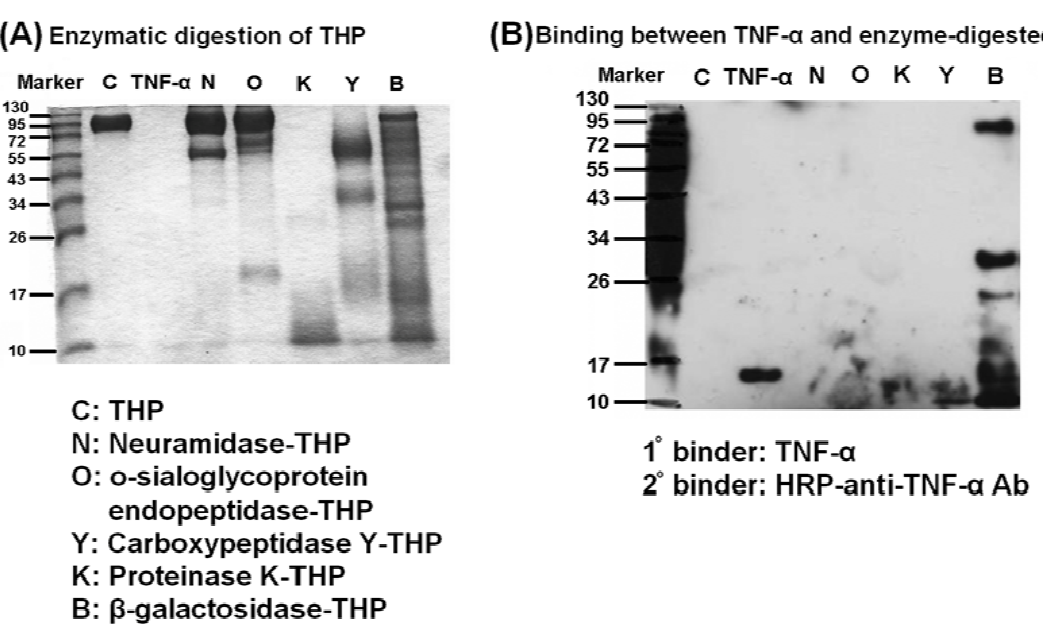
Figure 5. Binding capacity of intact THP and enzyme-digested products with TNF- α , was detected by Western blotting. ( A ) The molecular size of intact THP, TNF- α , and the different enzyme-digested THP products was identified by Coomasie blue staining. ( B ) The binding capacity of intact THP and enzyme-digested THP products was detected by